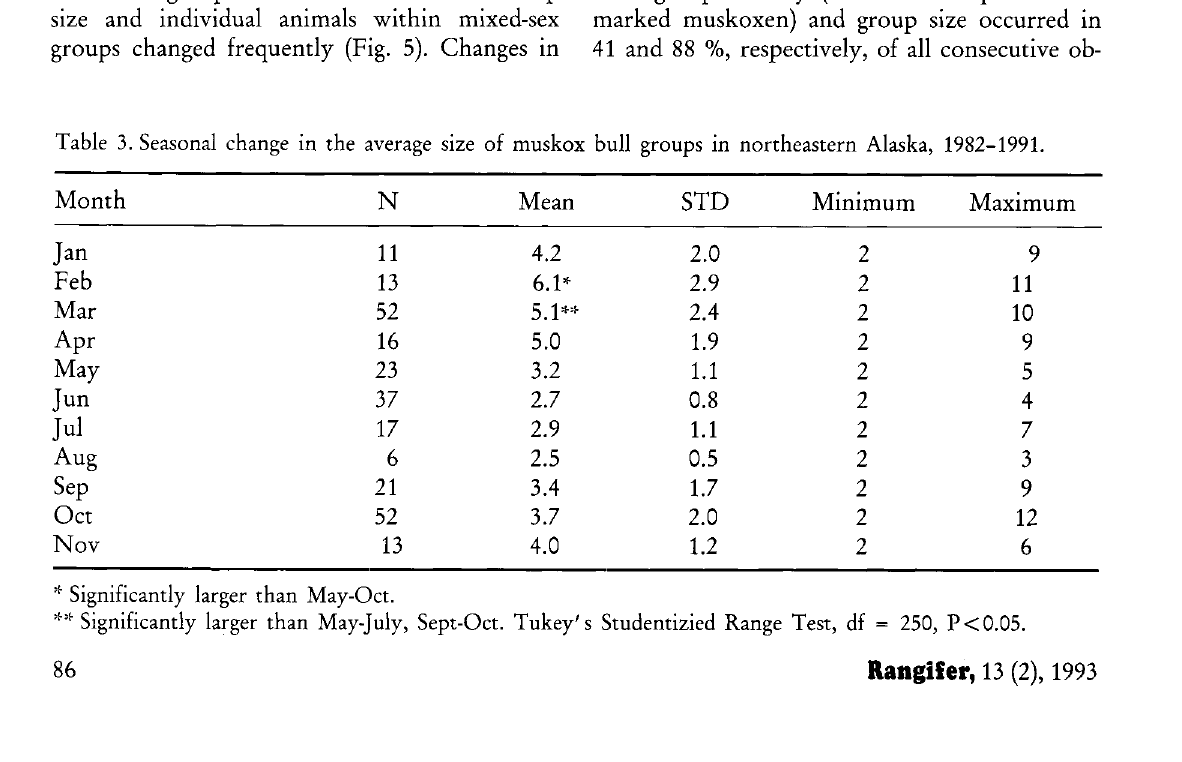
both group identity (based on the presence of marked muskoxen) and group size occurred in 41 and 88 %, respectively, of all consecutive ob-